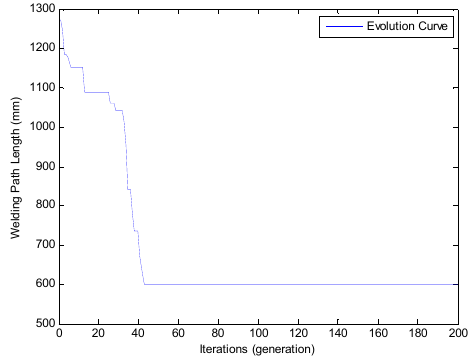
Figure 11. Iterative process of particle swarm optimization. Table 4. Particle swarm optimization parameters.